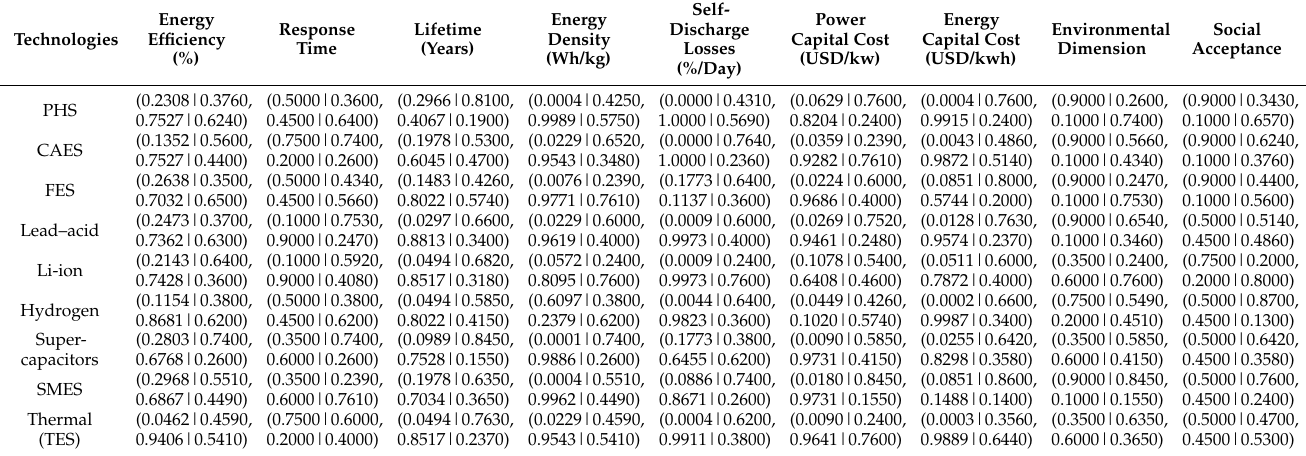
Table A4. Initial decision matrix of Expert